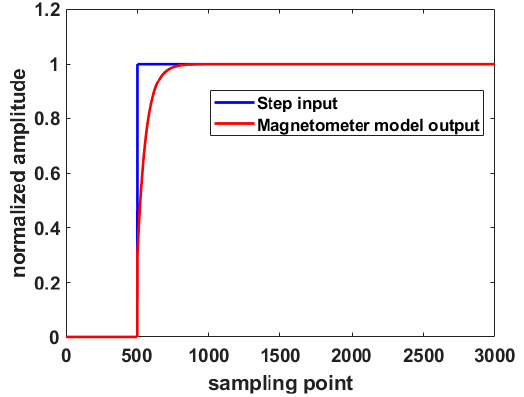
Figure 10. Step response curve of the magnetic sensor model.